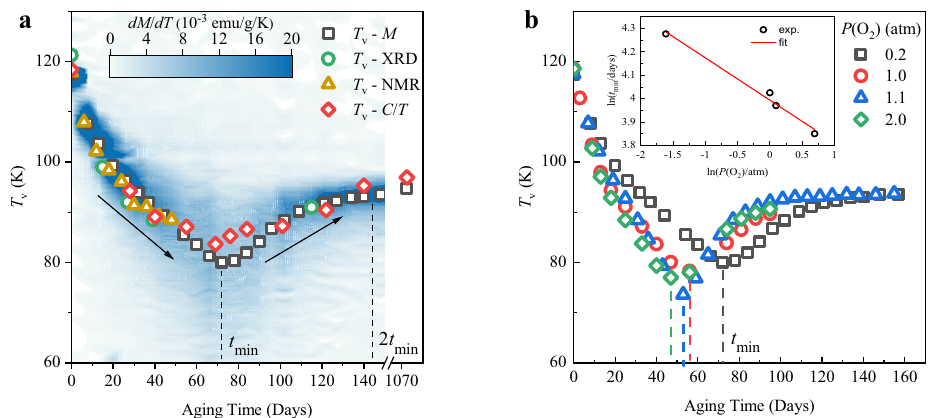
Fig. 3 Time and oxygen partial pressure dependence of the Verwey transition. a T V as a function of oxidation time. The squares, circles, triangles, and diamonds indicate T V as determined from the magnetization, the XRD measurements, the NMR spectra, and the heat capacity, respectively (details of T V determination are in “ Methods ” ). The dashed line indicates the oxidation time t min , at which the minimum of T V is observed (in magnetization data). The color-density represents the fi rst derivative of the magnetization, dM / dT , which shows how the Verwey transition is broadened around t min but then sharpens as the fi nal T V = 95 K value is reached near 2 t min . (b) Time variations of T V from magnetization measurements at different oxygen partial pressures. The inset shows the log – log plot of t min against P (O 2 ) with a linear fi